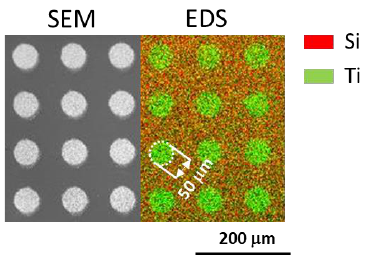
Figure 3. SEM ( left ) and EDS maps ( right ) of patterned Ti nanoparticle films deposited onto a Si wafer through a Si mask with an array of circular openings (50 µm in diameter). The false red color corresponds to Si; the green color corresponds to Ti.